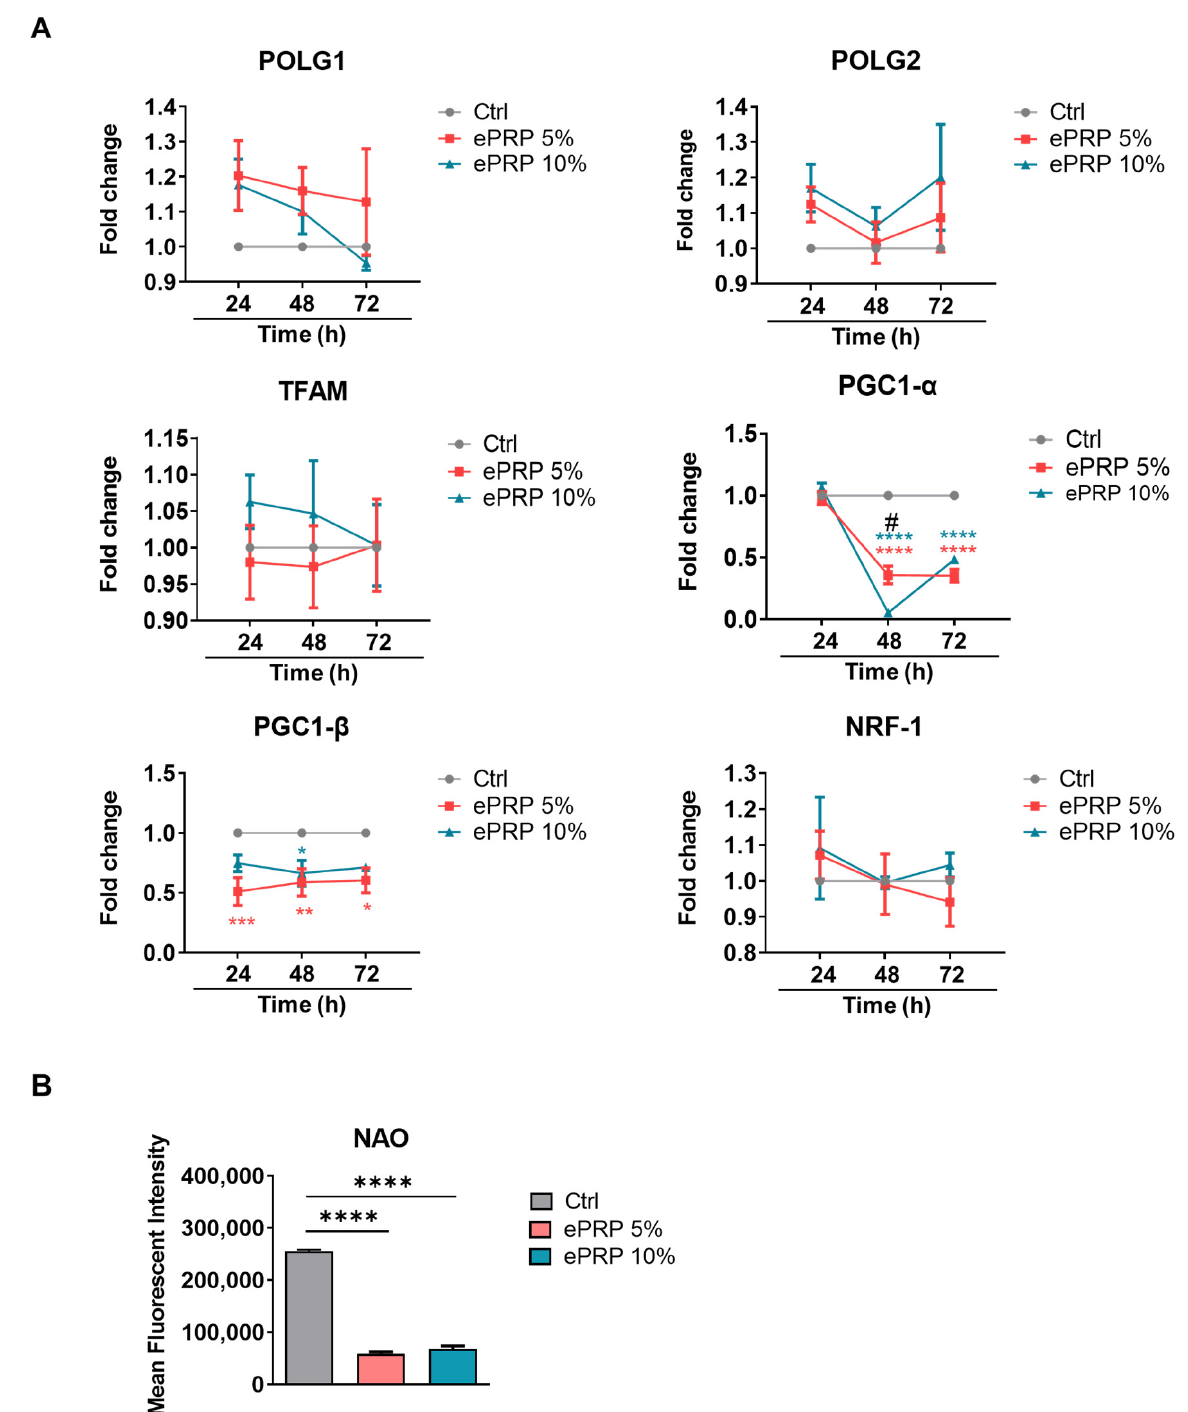
Figure 4. ePRP causes mitochondrial resetting by down-regulating mitochondrial biogenesis-related genes. ( A ) The line graph depicted the fold changes in mRNA expression levels of mitochondrial biogenesis-related genes in fibroblasts. Ct values were determined using quantitative real-time PCR for 24, 48, and 72 h after ePRP pretreatment. Two-way ANOVA with Tukey’s multiple comparisons test was used to determine statistical significance (* p < 0.05, ** p < 0.01, *** p < 0.001, **** p < 0.0001). * illustrates the statistical difference between each group; # shows the statistical difference between 24 and 48 h. The data are shown as mean ± SEM (N = 5). ( B ) Flow cytometry analysis for mitochondrial mass measurement. A representative bar chart of mitochondria stained with NAO is shown under indicated treatments. The results of an ordinary one-way ANOVA with **** p < 0.0001 and means ± SEM were shown (N =